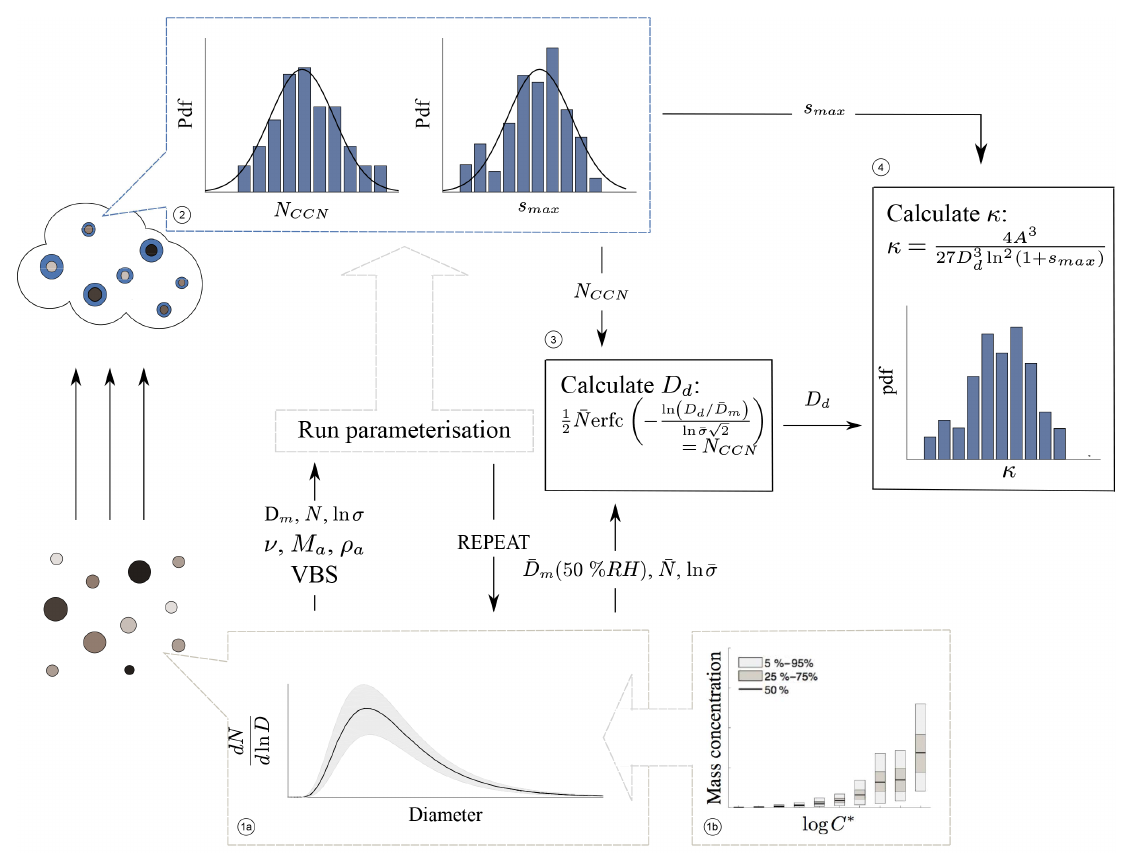
Figure 1. A schematic of the Monte Carlo method to calculate the hygroscopicity, κ . Mean size distribution and uncertainty range are shown in the plot of step 1a by the solid black line and grey shaded regions, respectively. The volatility basis set (VBS) and uncertainty range used in Sect. 3.1 are shown in the additional plot of 1b. The blue bar charts in step 2 show the probability distributions of N CCN and s max generated from the Monte Carlo simulations that are run using the size distribution parameters and the volatility distributions from step 1. Randomly chosen van ’t Hoff factors ( ν ), molecular weights ( M a ) and densities ( ρ a ) of the aerosol components are also input into the parameterisation. Normal distributions of N CCN and s max are fitted to the bar charts and are shown by the overlaid solid black lines. Step 3 combines the mean size distribution of dry aerosol at 50% RH with randomly sampled N CCN to calculate a range of D d . In step 4, each D d is used together with a randomly sampled s max to find the range of κ .